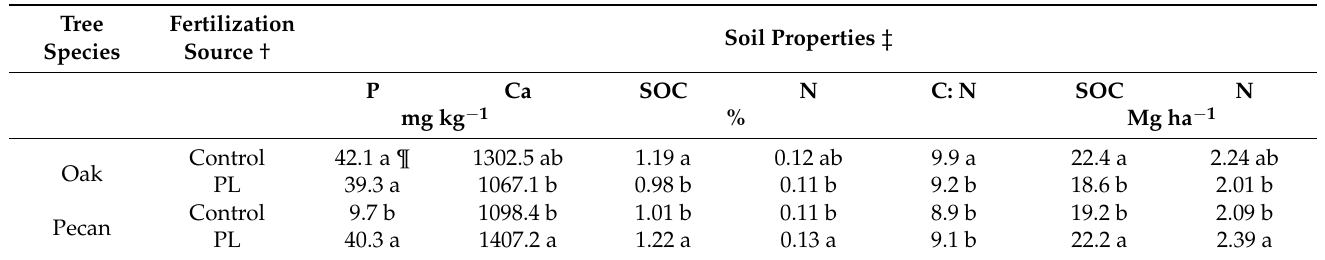
Table 4. Soil chemical properties in a 17-year agroforestry site in Fayetteville, AR (collected in 2016), per tree species and fertilization treatment, averaged across soil depth (0–15 and 15–30